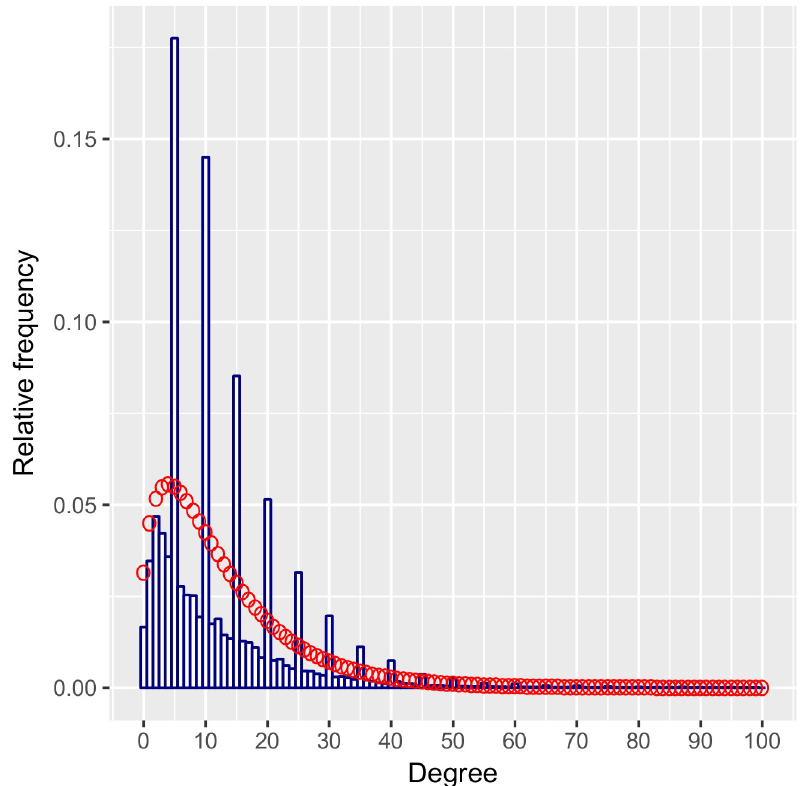
Fig 4. Histogram of multiply imputed distribution of reported degree overlaid with fitted underlying degree